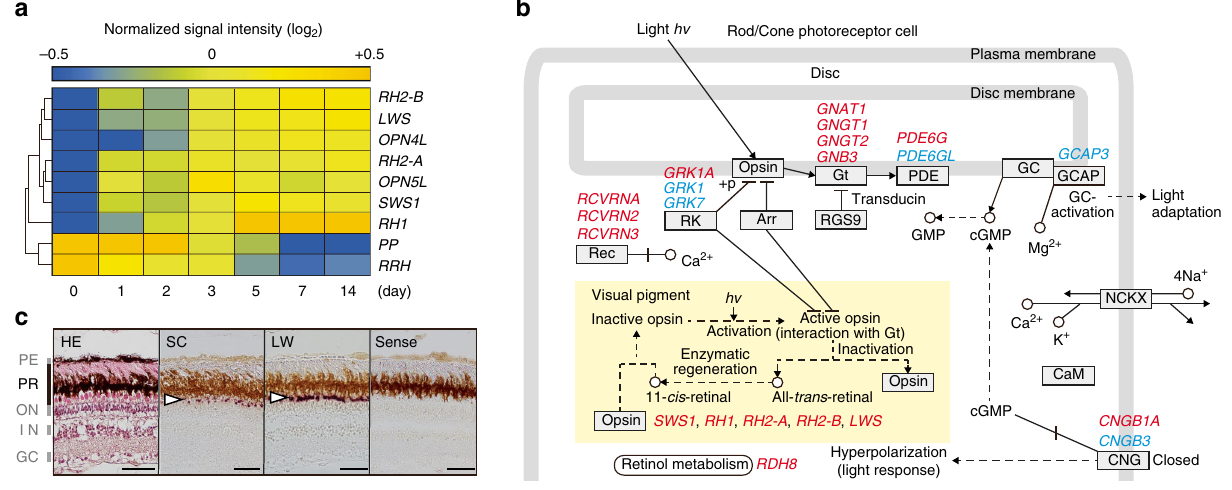
Fig. 2 Genome-wide expression analysis of the eye reveals dynamic seasonal changes in phototransduction. a Clustered organization of seven upregulated and two downregulated opsin genes following a long day/warm temperature (LW) stimulus. Data were normalized over the complete data set. The color scale represents the normalized signal intensity. b Seasonal changes in the expression of genes encoding photopigments and their downstream phototransduction pathways. Gene symbols in red and blue indicate up- and downregulated genes, respectively. Adapted from the KEGG (Kyoto Encyclopedia of Genes and Genomes) phototransduction pathway. c In situ hybridization analysis con fi rmed LW induction of LWS opsin in the photoreceptor layer ( GC ganglion cell layer, IN inner nuclear layer, ON outer nuclear layer, PE pigment epithelium, PR photoreceptor layer). Representative images from the central area of the retina (also see Supplementary Fig. 6). White arrow indicates the hybridization signal. Scale bar : 50 µ